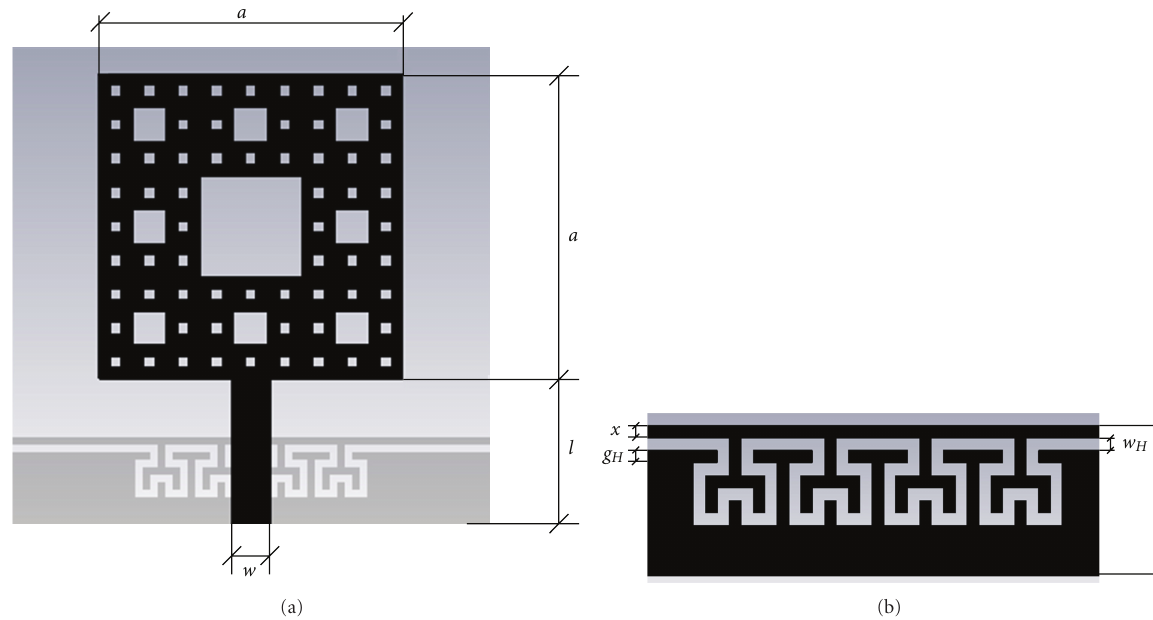
Figure 1: (a) Proposed fractal antenna on a Hilbert slot patterned ground (black: top metallic layer, dark gray: bottom metallic layer); (b) magnified detail of the patterned ground under the feed line (black: bottom metallic